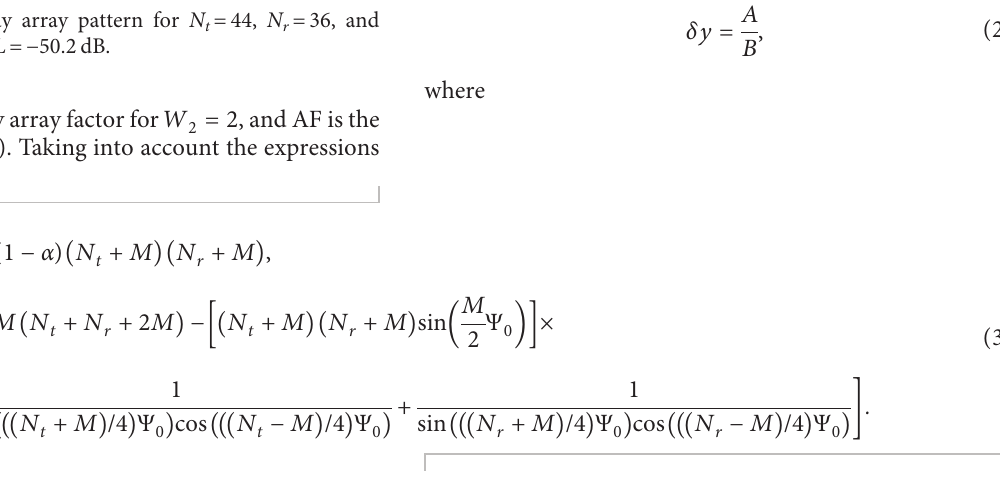
� 44, N � 36, and t r